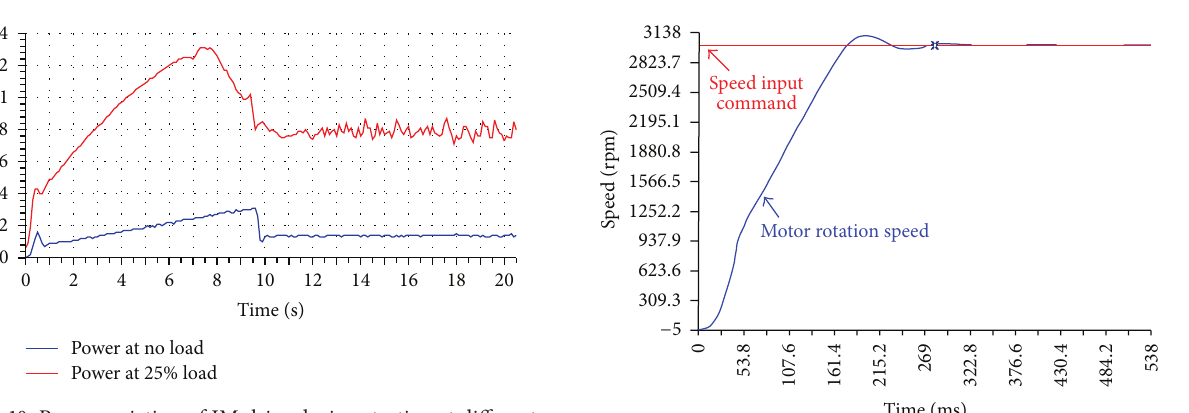
Figure 10: Power variation of IM drive during starting at different loads and 1440rpm speed.